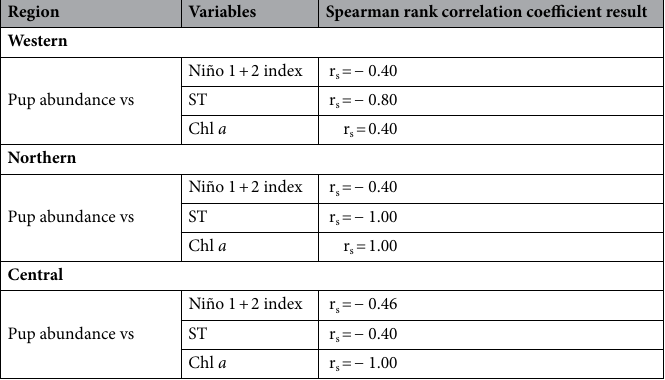
Table 6. Spearman’s rank correlation coefficient results. Relationships between Galapagos fur seal pup abundance per region of the archipelago and environmental variables from 2014 to 2018 for Niño 1 + 2 index and without 2017 data for subthermocline temperature (ST) and Chlorophyll-a (Chl a ). No relationship was significant at p =